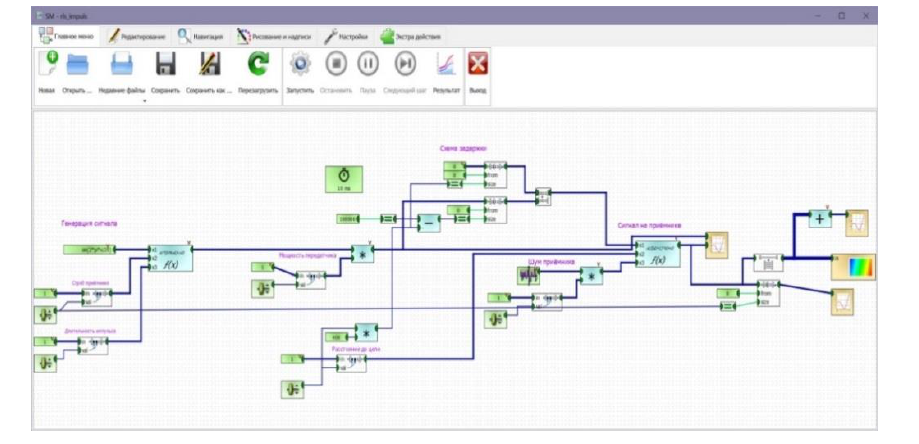
Fig. 5. Block diagram window of signal processing device